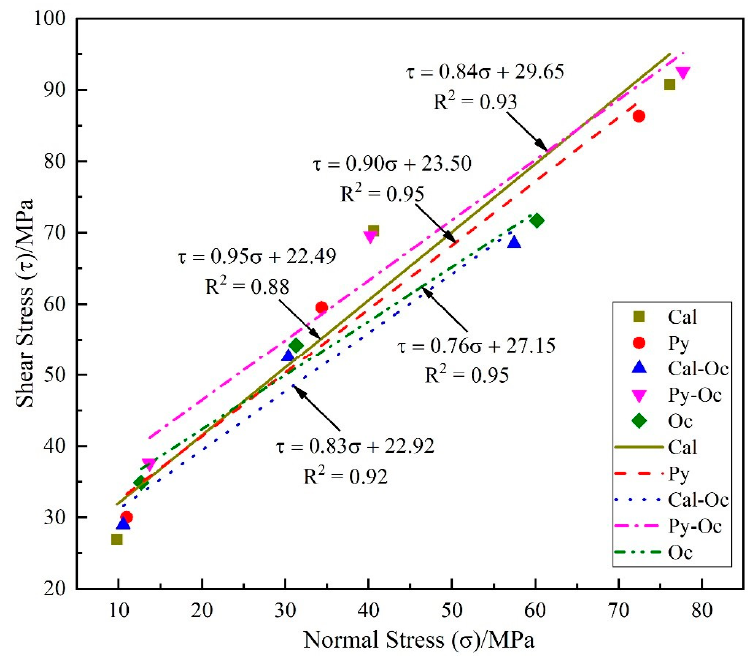
Figure 6. Shear stress and normal stress curve of the Longmaxi Shale laminae under angle-varied plate shear conditions.